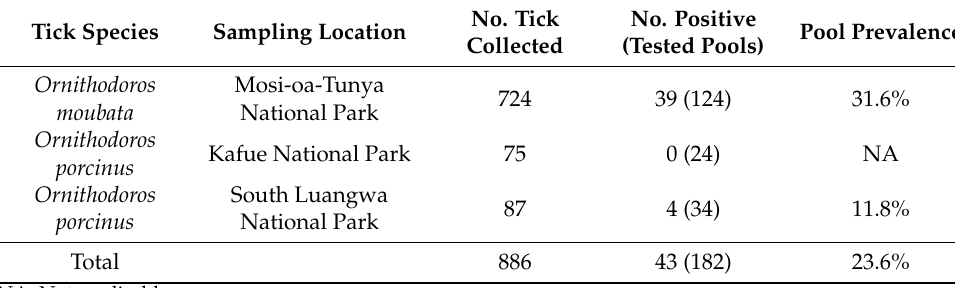
Table 1. Results of borrelia screening using flaB nested-PCR .